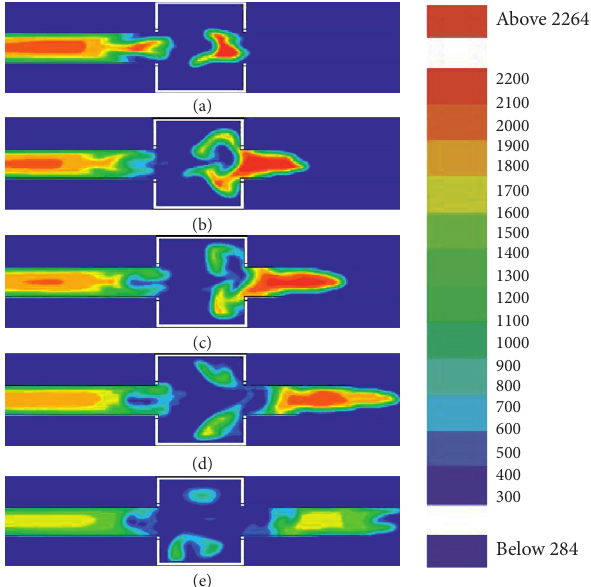
Figure 8: Photograph of gas explosion experimental system.